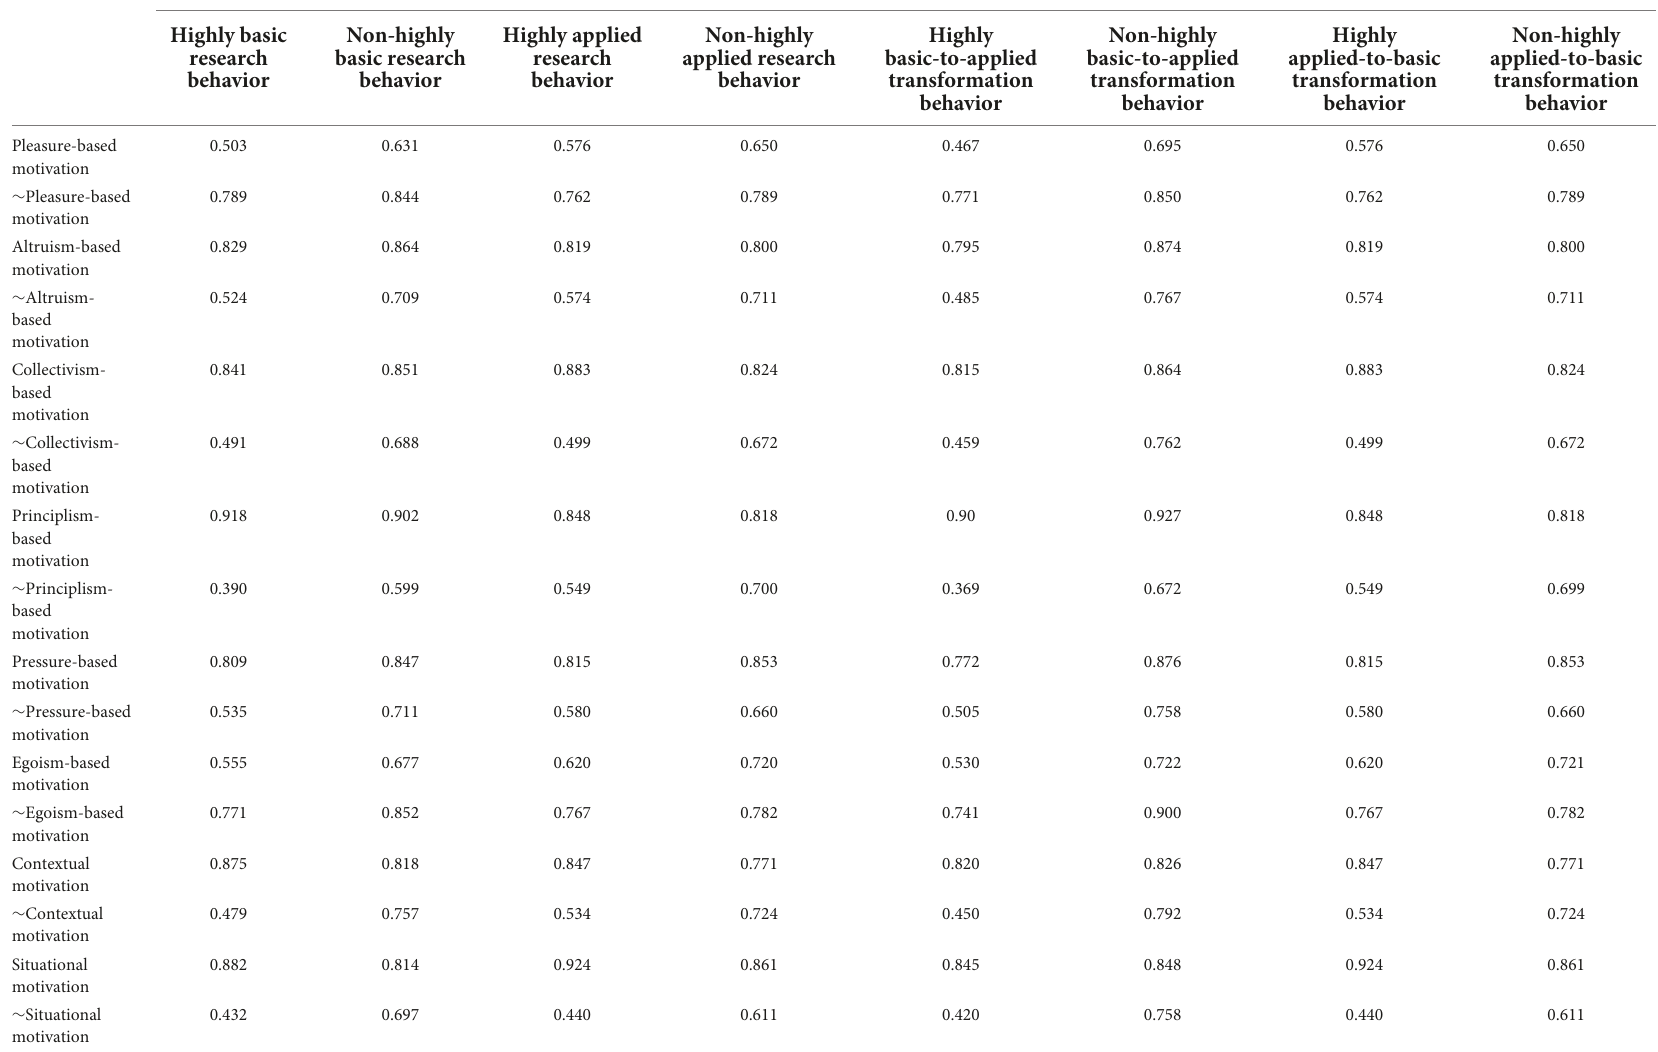
TABLE 4 Necessity test of the previous